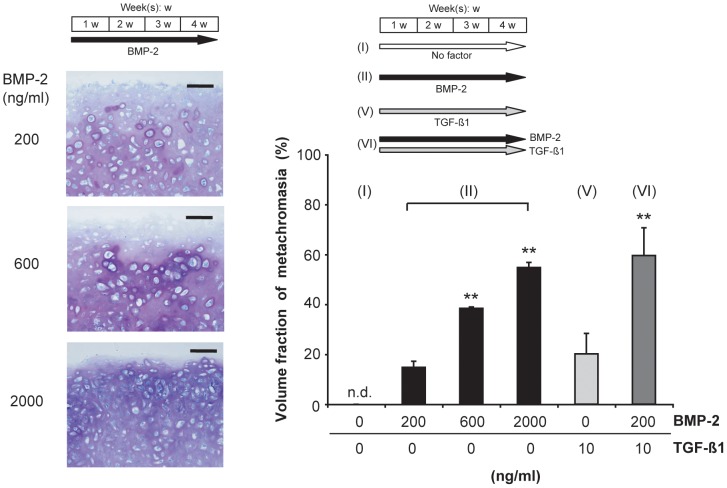
Dose-dependency of the BMP-2-induced chondrogenic differentiation of synovial explants.Light micrographs (left) of Toluidine-Blue-stained sections through explants that had been cultured for 4 weeks in the presence of BMP-2 at 200 ng/ml, 600 ng/ml or 2000 ng/ml, and graph (right) depicting the volume fraction of metachromasia in each case, as well as within explants that had been exposed for 4 weeks either to TGF-ß1 alone (10 ng/ml) or to the TGF-ß1 (10 ng/ml)/BMP-2 (200 ng/ml) combination. In the graph, mean values for n = 4 animals (4 explants in each case) are represented together with the SEM. n.d.: not detectable; **: p<0.01 vs. “BMP-2 (200 ng/ml)”. Bars = 100 µm.